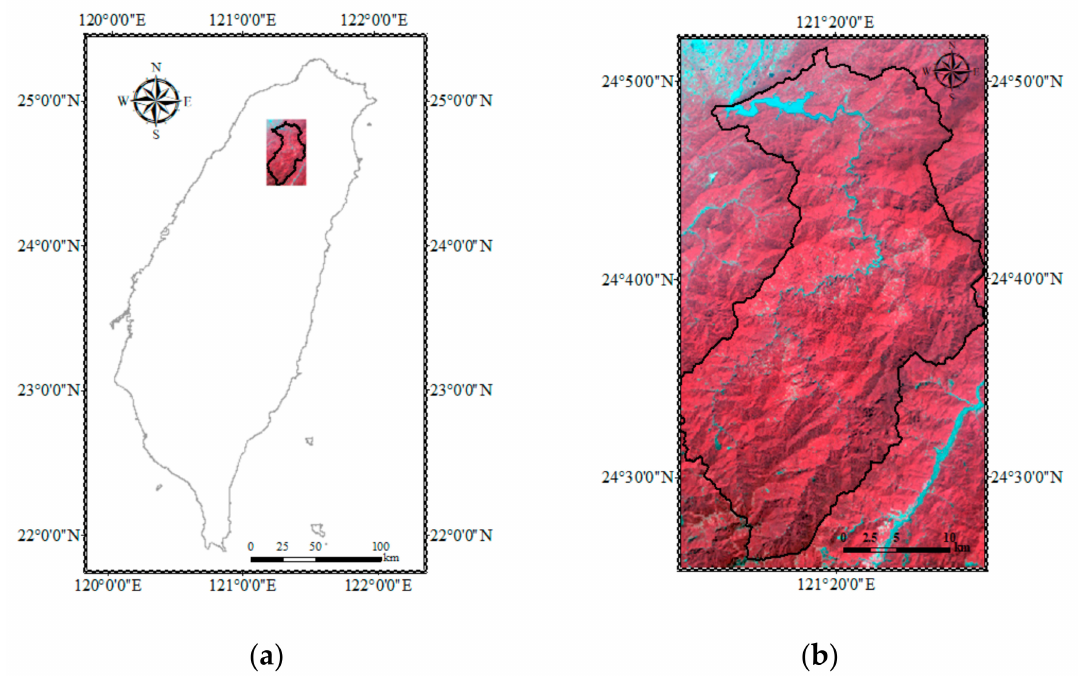
Figure 1. Study area and SPOT-5 satellite image. ( a ) Location with a false-color image, ( b ) zoomed-in image of the